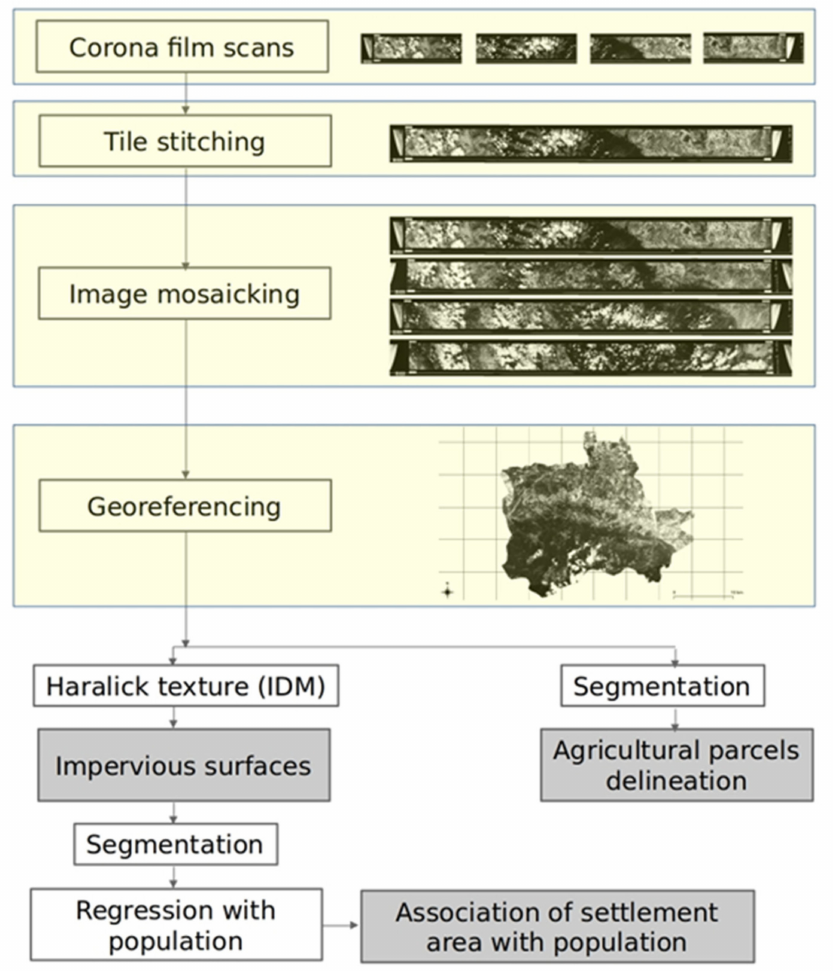
Figure 3. Workflow of the Corona satellite image processing and population analysis. Yellow fields correspond to satellite image mainstream pre-processing, transparent fields to image manipulation and grayed fields in workflow products presented in the results